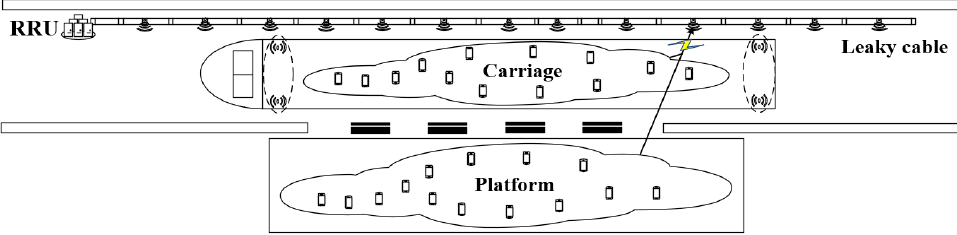
Figure 6. Interference analysis of LTE-M with leaky cable radiations pattern.